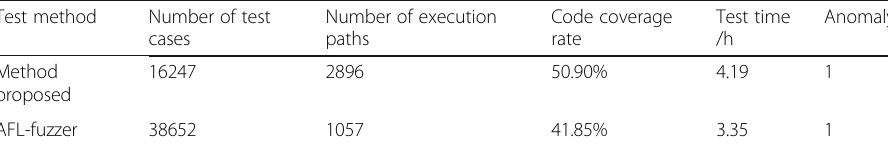
Table 3 Comparison results of experiment Test